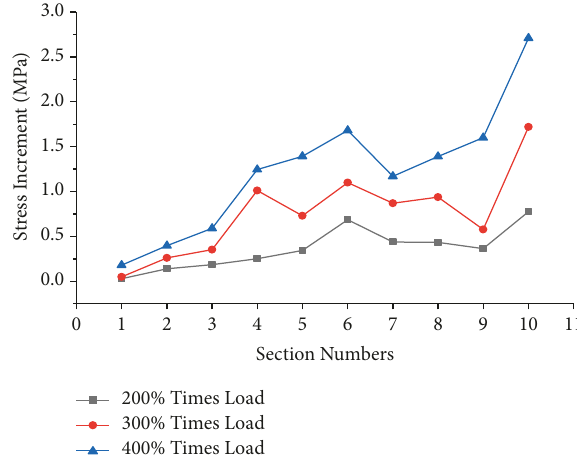
Figure 9: Stress variation of the main beam under 200% ∼ 400% times